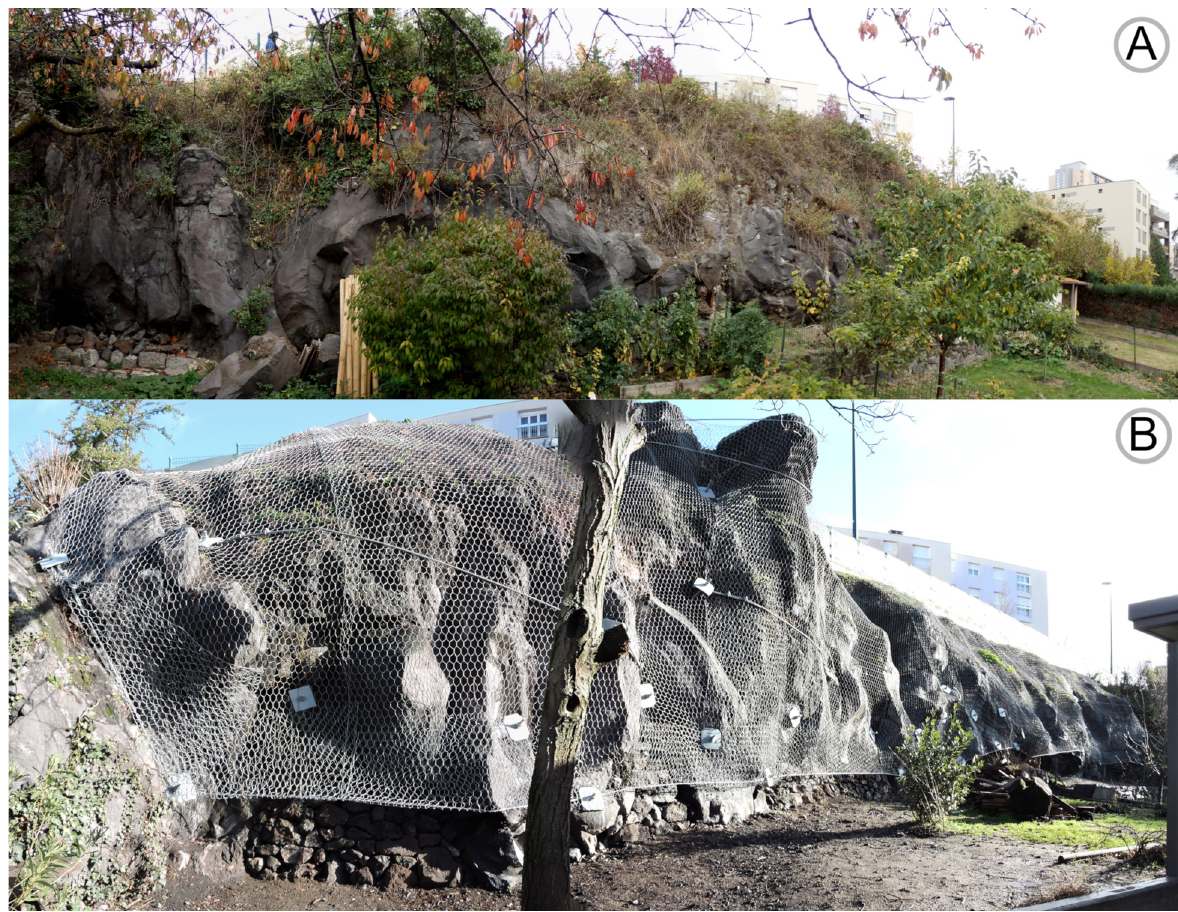
Fig. 9. The outcrop of Grave Noire lava flow at Impasse Dr. Cohendy (CF1212). A – before the stabilization. B – after the stabilization with bolting and mesh. While we still think that the meshing is an overreaction, it is a com - promise between total destruction and the perceived